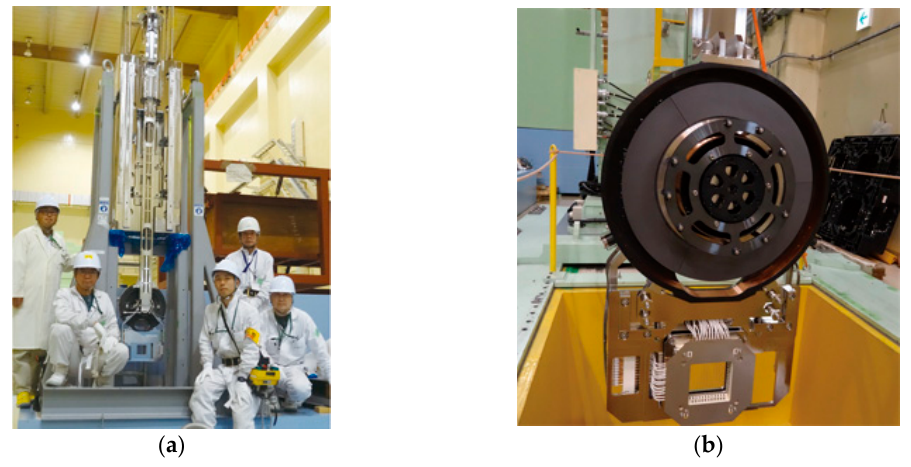
Figure 4. Pictures of ( a ) the rotating muon target assembly; and ( b ) the rotating muon target itself. Table 1. Measured and simulated temperatures of the horizontal shaft and maximum simulated temperatures of the graphite at typical beam powers. 300